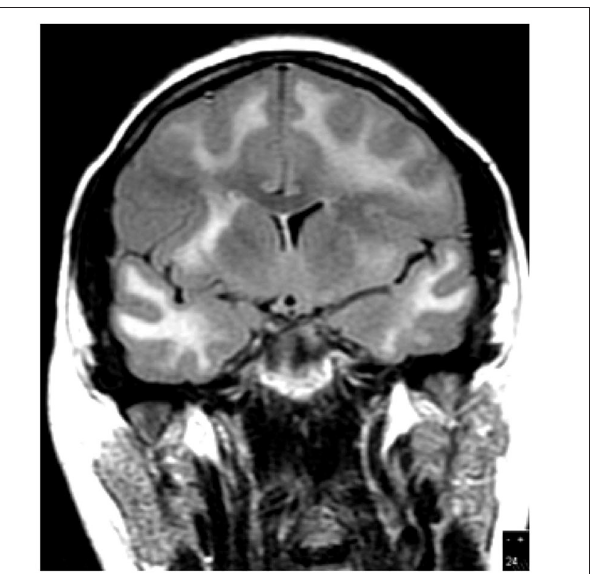
FIGURE 2 | Case 7: Brain MR imaging (coronal T2-weighted image) demonstrating extensive white matter